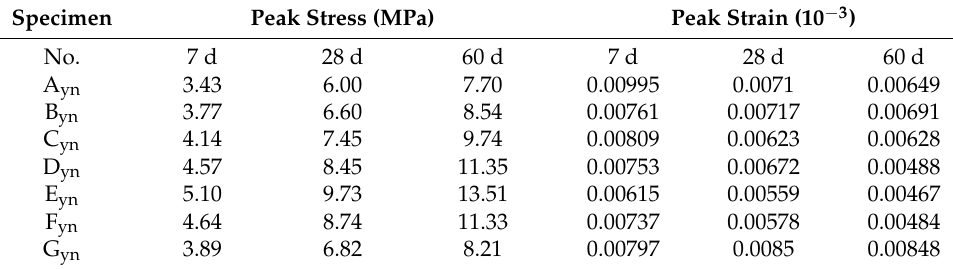
Table 4. Impact Compression Test Results for Ni-Fe Slag Powder Soil Cement.